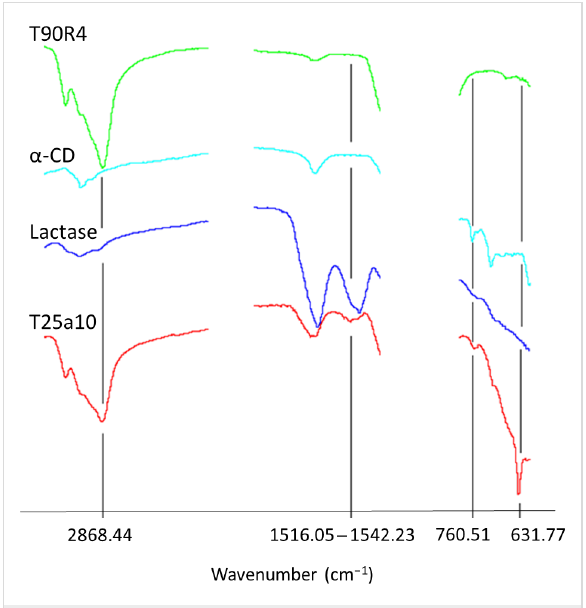
Figure 3: FTIR spectra of Tetronic 90R4, α -CD, lactase and T25a10 complex.